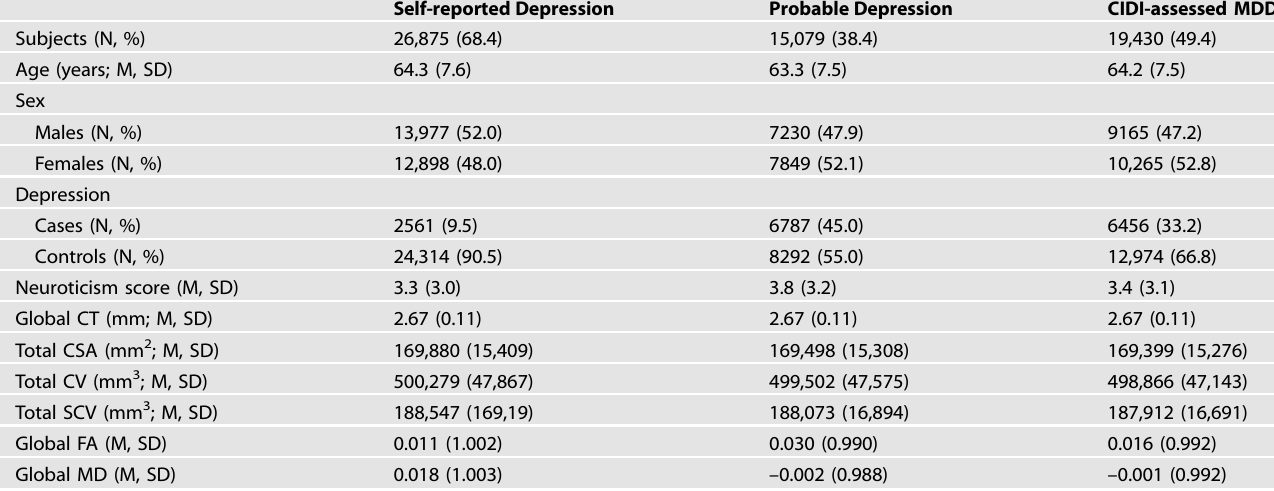
Table 1. Descriptive statistics for each lifetime depression